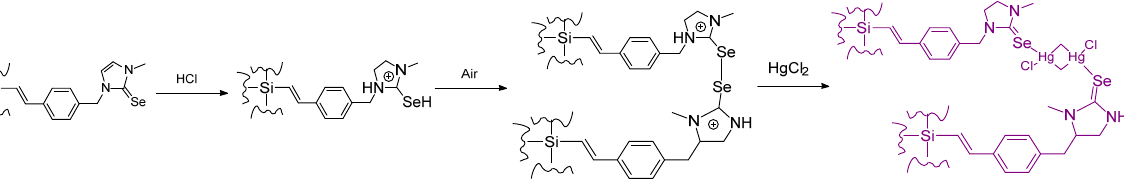
Figure 24. The polyhedral and oligomeric silsequioxane based compound POSS – Se serving as a chemosensor, by Liu et al.